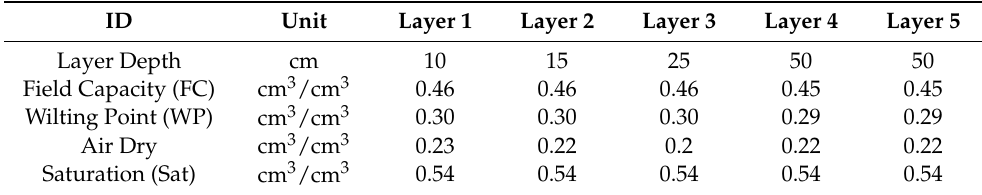
Table 5. Soil parameters, calibrated by crossing [50,51]. They were kept constant during EnKF- SAFY_swb run.